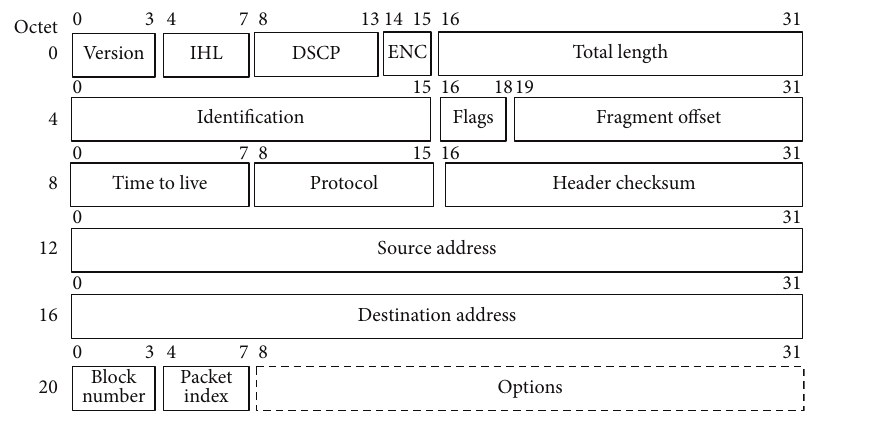
Figure 6: Data packet format in RMBTM.